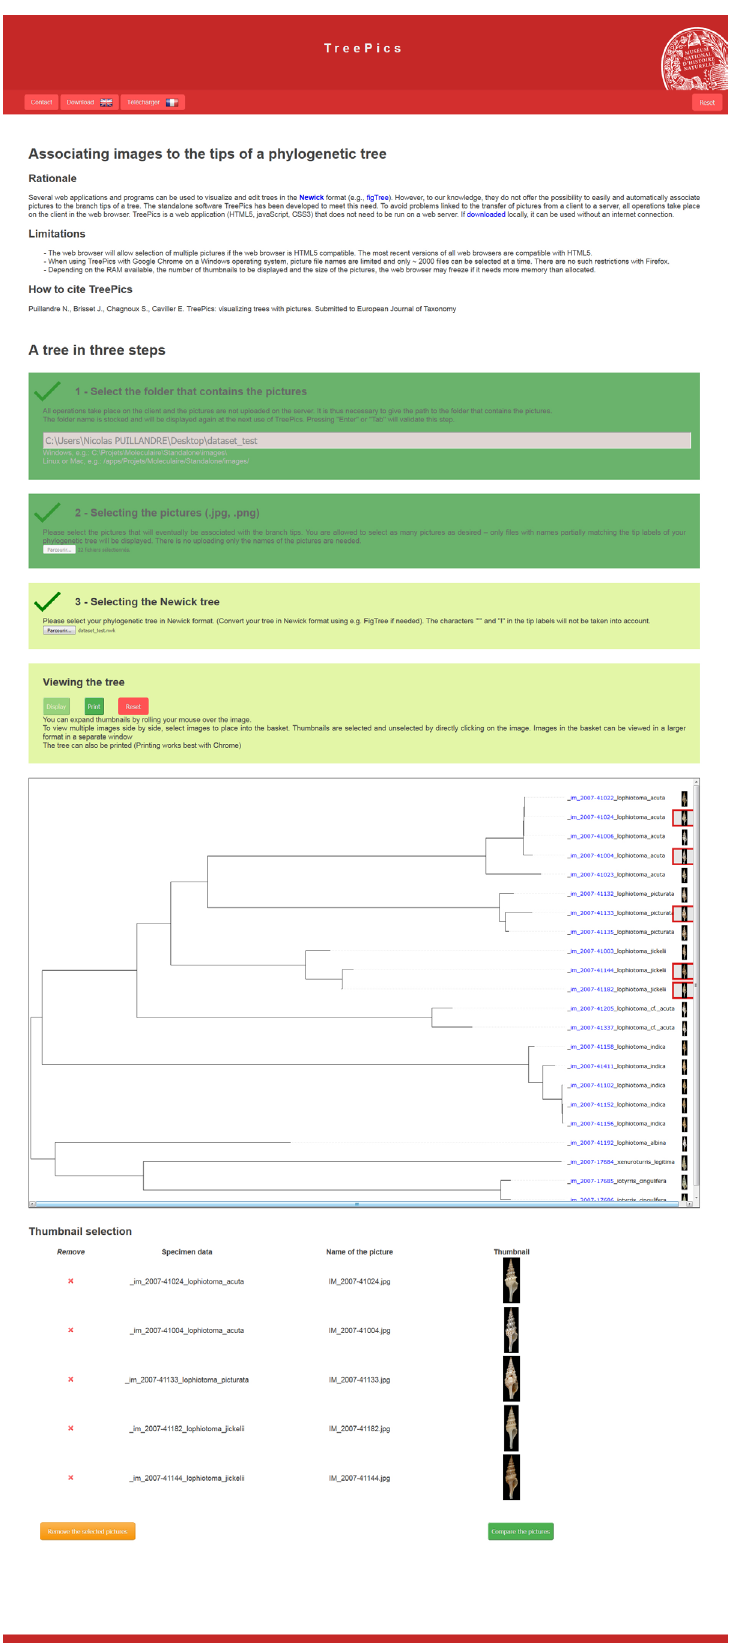
Fig. 1. Screenshot of the page with tree visualizations and associated images, showing the phylogenetic trees and the associated thumbnails. The selected thumbnails (red squares) also appear in the list below the